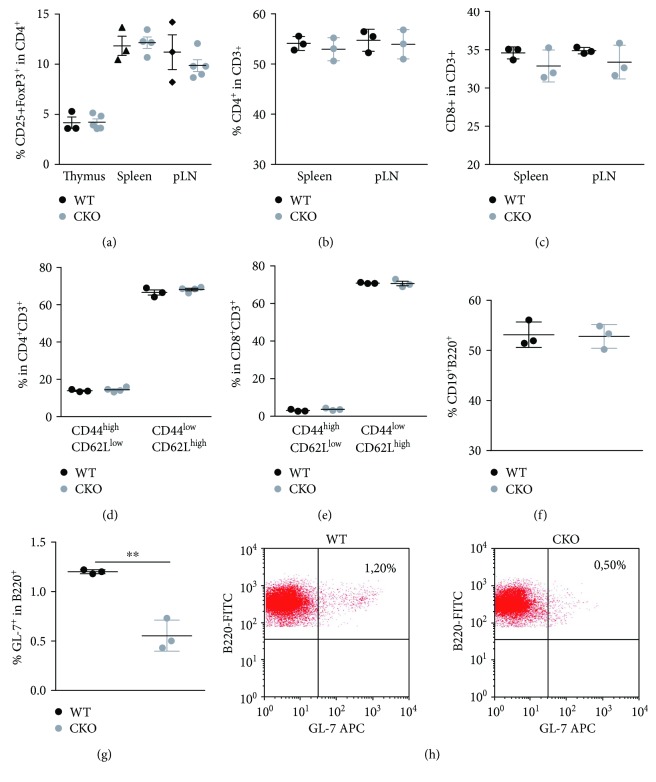
CREB expression in DCs is not necessary to preserve T-cell homeostasis but alters B cell activation: (a) percentages of CD25+Foxp3+ cells within CD4+ T cells in different lymphoid organs of indicated mice determined by flow cytometry; (b) percentages of CD4+ within CD3+ T cells in spleens and pLNs of indicated mice determined by flow cytometry; (c) percentages of CD8+ within CD3+ T cells in spleens and pLNs of indicated mice determined by flow cytometry; (d) percentages of naive (CD62Lhigh, CD44low) and memory (CD44high, CD62Llow) cells within CD4+ T cells; (e) percentages of naive (CD62Lhigh, CD44low) and memory (CD4high, CD62Llow) cells within CD8+ T cells; (f) percentages of CD19+B220+ cells in spleen of indicated mice; (g) percentages of GL-7+ cells within CD19+ cells, unpaired, two-tailed Student's t-test, p = 0.0021; (h) representative dot plots showing GL-7+ cells within B220+ population. For (a–g), each dot represents an individual mouse, and horizontal bars indicate SEM. ∗∗p < 0.01.